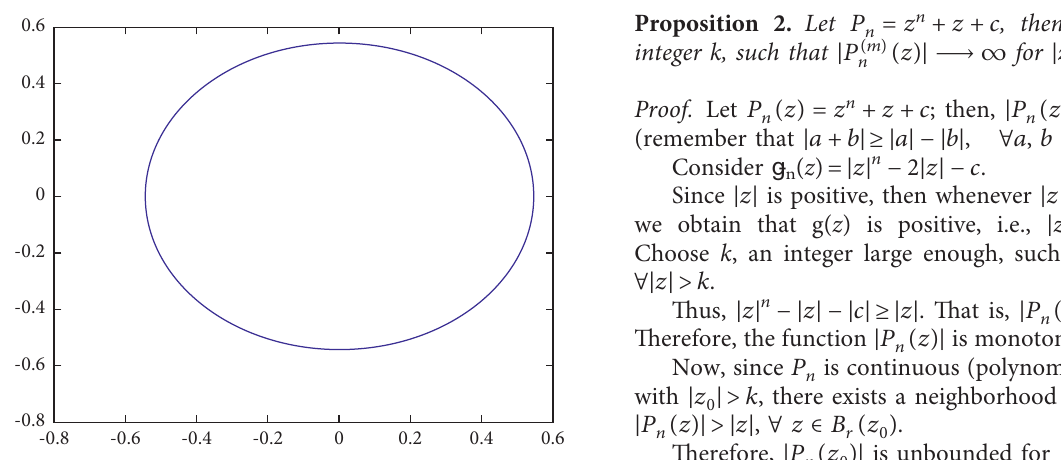
Figure 11: The boundary of fixed point of period one for P